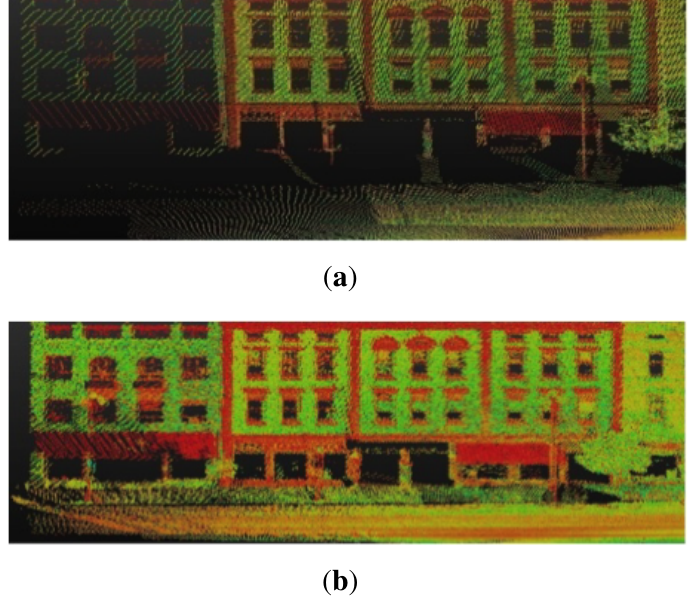
Figure 15. Different missing features and imperfections belonging to shop windows, walls, pole and road in ( a ) are successfully completed and removed in ( b ), respectively, using this method for neighborhood-1. (a) 3D point cloud, P ( n ) , after fourth passage. cloud, P ( n p